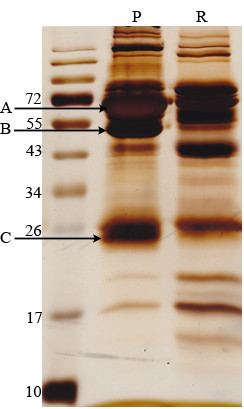
Removal efficiency of serum high-abundant proteins. 40 μl of healthy human plasma was processed with the ProteoExtractTM Albumin Remove reagent. 50 μg protein from each fraction was separated by SDS-PAGE and visualized by silver staining. The aggregation of HAS (A); IgG heavy chain (B) and IgG light chain (C) was greatly reduced. P: human plasma, R: plasma without high-abundant proteins.